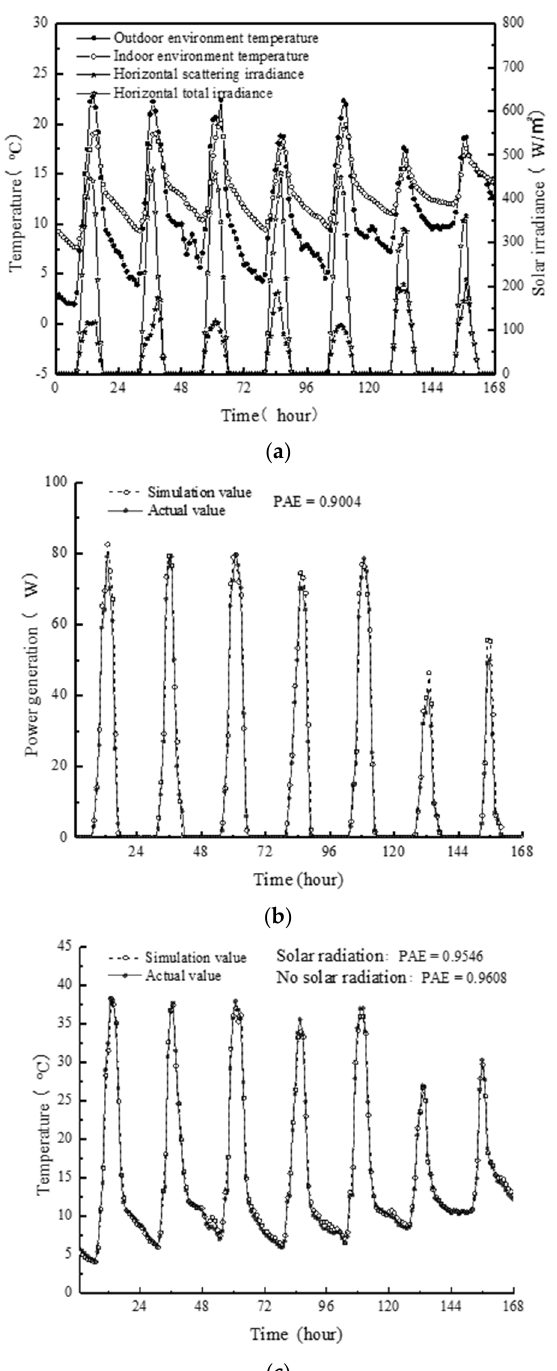
Figure 4. Comparison between simulated and measured values of ST-PVW in Nanjing: ( a ) Outdoor meteorological condition; ( b ) Comparison of hourly power generation of photovoltaic modules; ( c ) Comparison of glass temperature on inner surface of PV cell. Table 1. Simulation input parameters of ST-PVW.